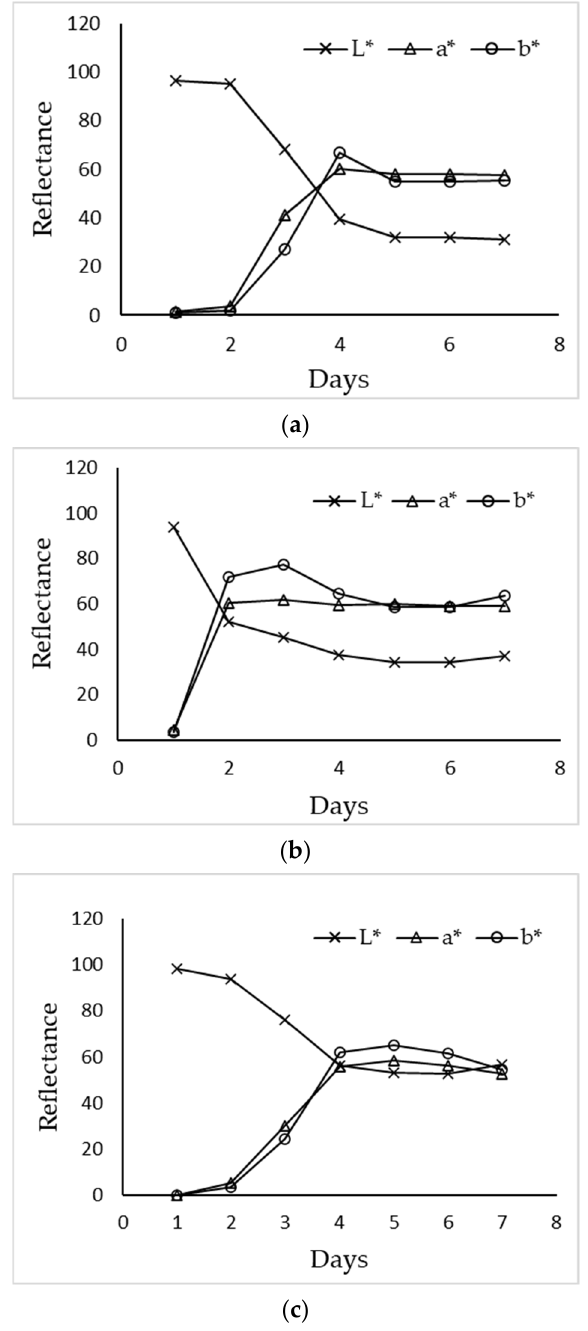
Figure 10. Color CIEL*a*b* values of pigments produced by T. albobiverticillius 30548 measured by colorimetric system (D65) with pO 2 set at ( a ) 50%, ( b ) 70% and ( c ) 90%. In the fermentation with 90% pO 2 , red and orange hues were observed, which is well identified from the coordinate values at day 7: L* (56.87), a* (52.86) and b* (54.61). From day 1 to day 4, there was a notable change in a*, b* coordinates similar to run 1, but not with respect to L* values (Table 6). In this run, lightness L* value remained around 56.87 on day 7, higher than the values obtained in run 1 (31.24) and run 2 (36.94). The difference